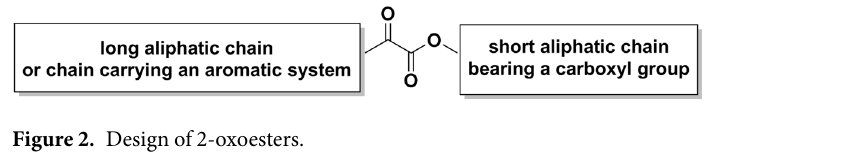
Figure 2. Design of